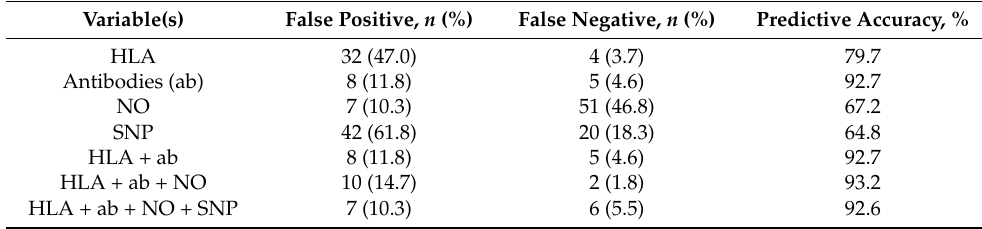
Table 3. Predicted values in the logistic regression for the different variables and the overall predictive accuracy of correct classification into the CD ( n = 109) or non ‐ CD ( n = 68) groups.